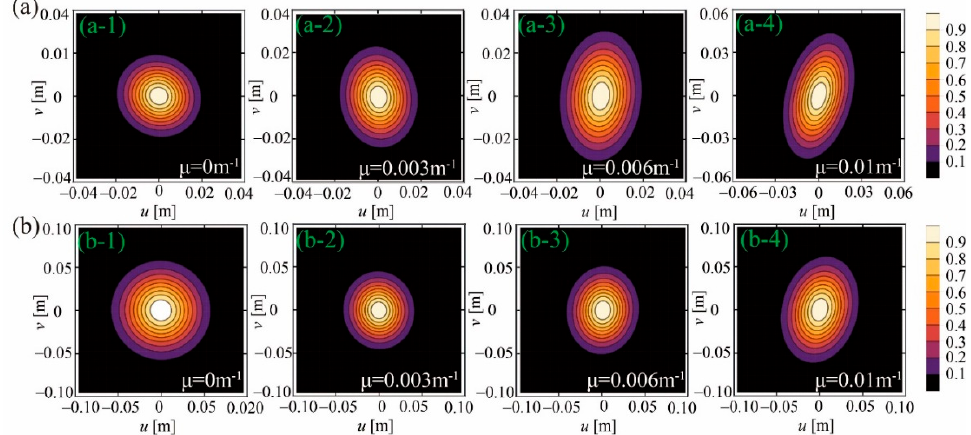
Figure 4. Normalized spectral density (contour graph) of the TGSM beam at propagation distance z = 0.3 km for di ff erent twist factors. ( a ) in free space; ( b ) in oceanic turbulence. E ff ective beam width, beam coherence width and twist factor are useful parameters to characterize the beam spreading and coherence properties during propagation. This information can be